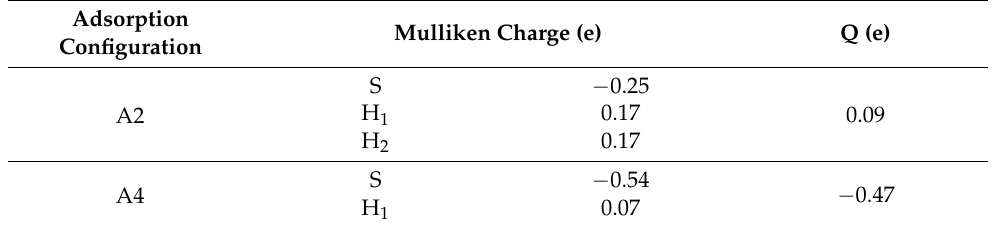
Figure 7. The Mulliken charge population analysis of H 2 S adsorption on the α -Fe 2 O 3 (001) surface. ( a ) Three dimensional drawing of the Mulliken charge population for A2 configuration; ( b ) Two dimensional drawing of the Mulliken charge population for A2 configuration; ( c ) Three dimensional drawing of the Mulliken charge population for A4 configuration; ( d ) Two dimensional drawing of the Mulliken charge population for A4 configuration. Table 2. The Mulliken charge population analysis of H 2 S adsorption on the α -Fe 2 O 3 (001)